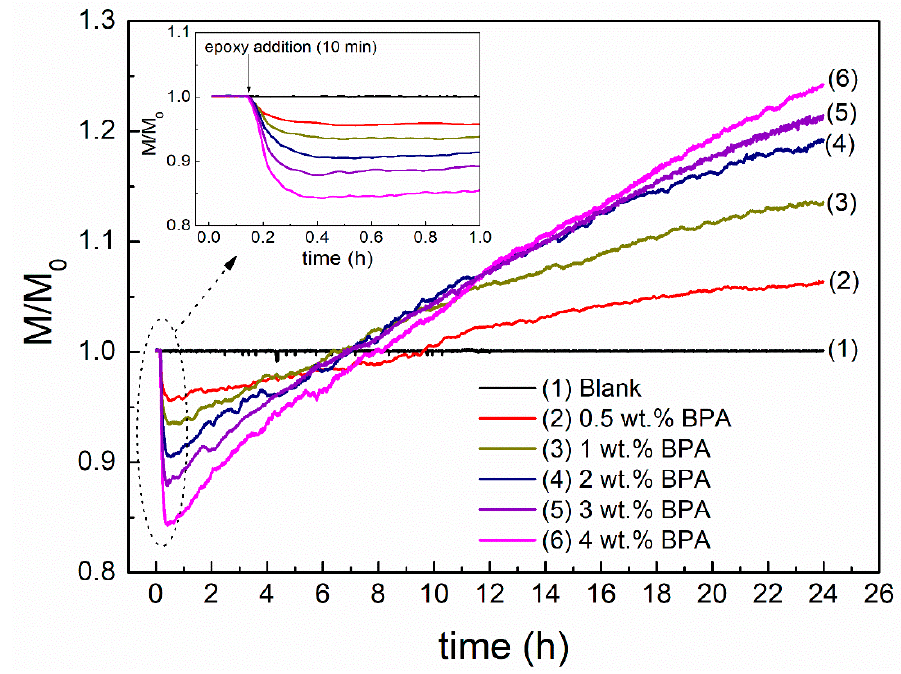
Figure 1. Evolution of relative mixing torque during processing as a function of the added epoxy concentration.